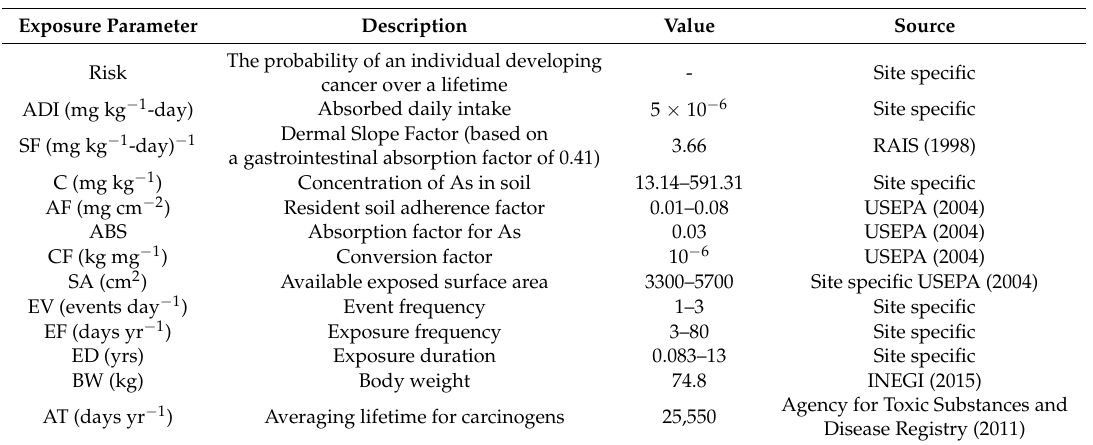
Table 1. Risk characterization methodology according to USEPA (2004).